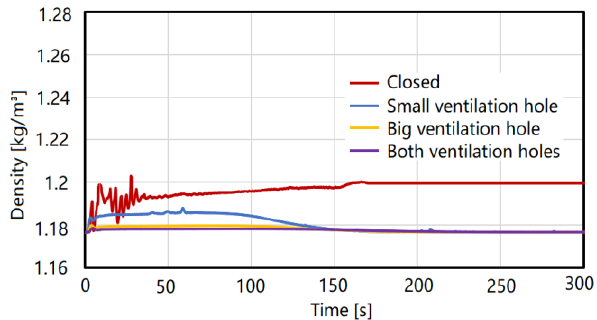
Figure 10. Density with different ventilation levels.